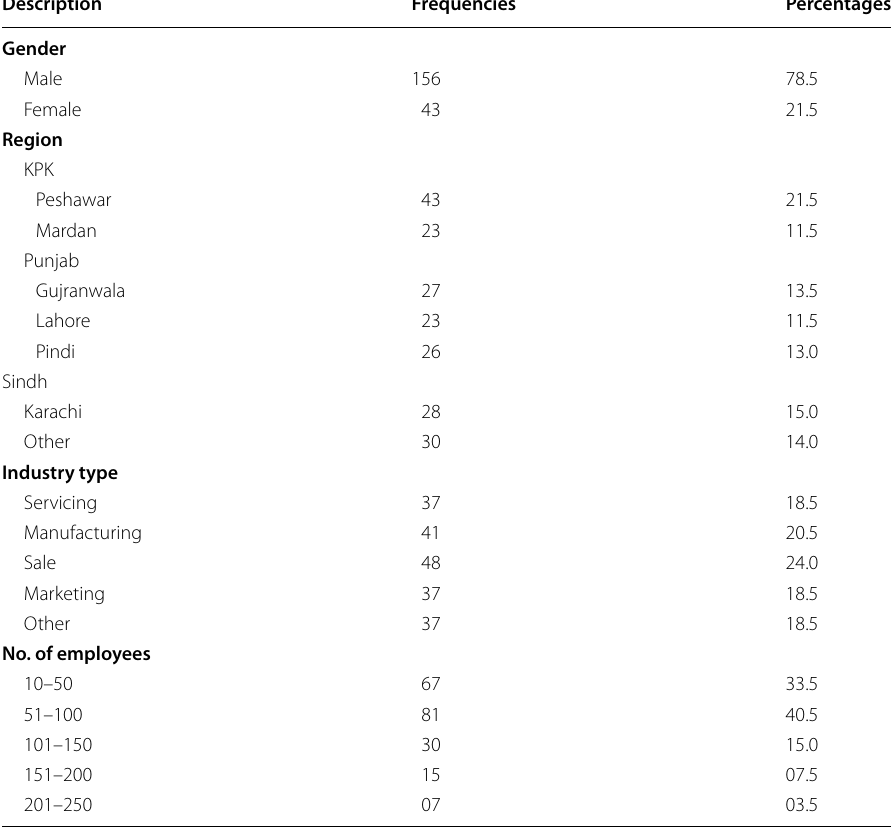
Table 1 Profile summary of the SMEs and